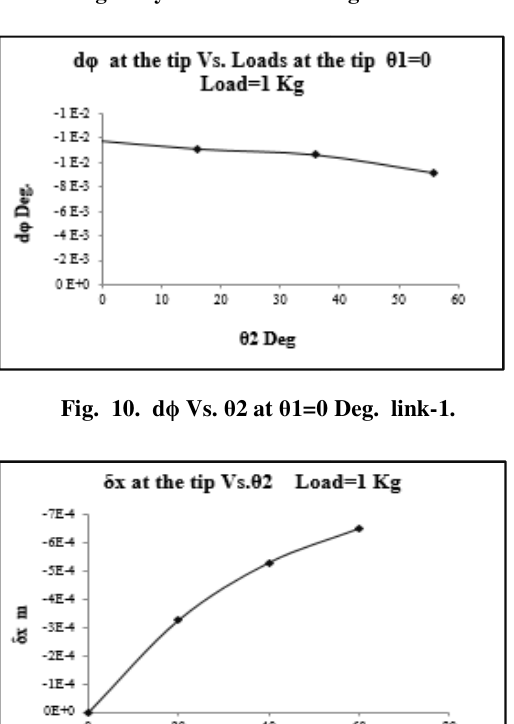
Fig. 9. δ y Vs. θ 2 at θ 1=0 Deg. link